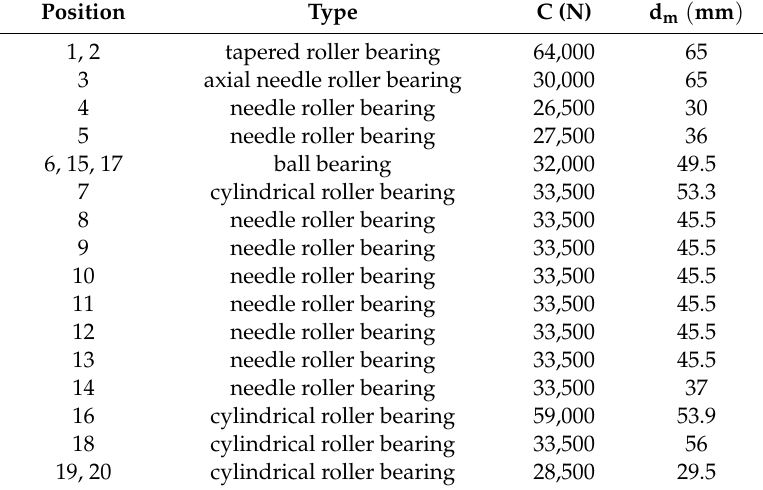
Table A1. Bearing parameters. Position according to Figure 2. Dynamic load rating C and mean diameter d m .